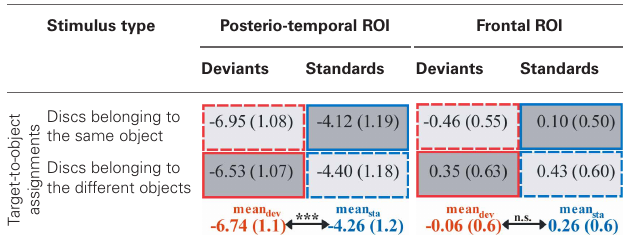
Table 2 | Mean amplitudes ( μ V) elicited by deviants (red outlines) and standards (blue outlines) at posterio-temporal ROI (electrodes P5/6, P7/8, PO7/8) and frontal ROI (electrodes AF3/4, F3/4, F5/6) in the N2-latency